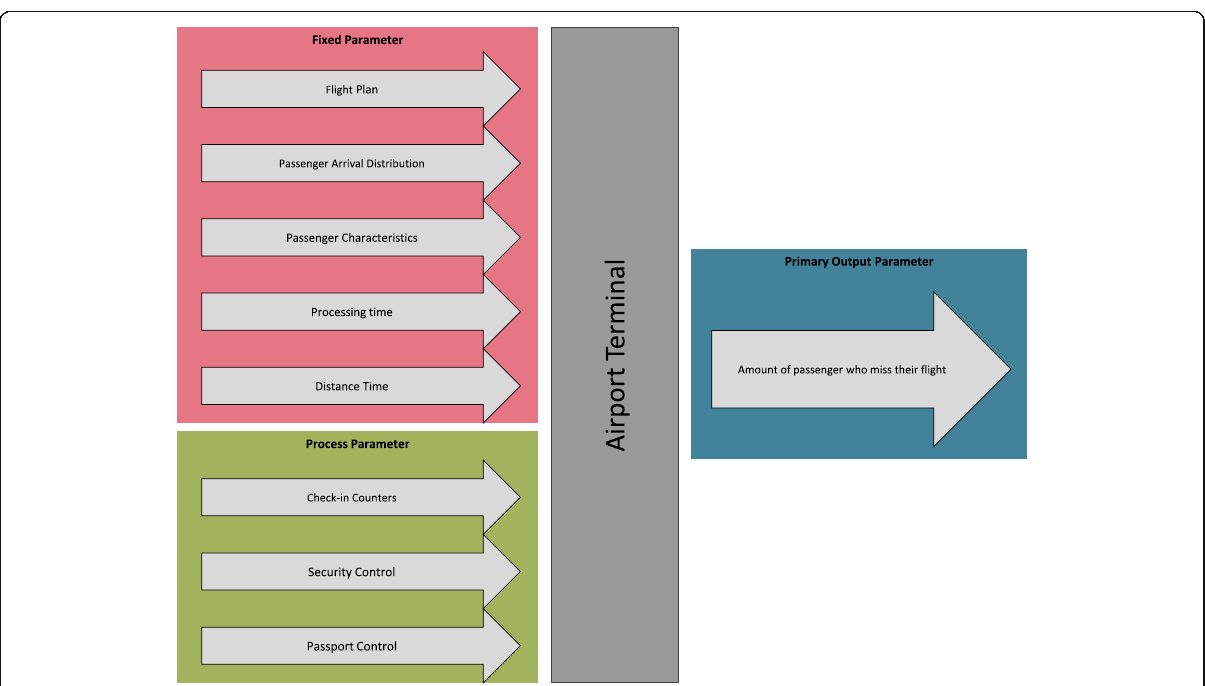
Fig. 3 Overview of the input and output parameters of the simulation. Input parameters are divided into fixed and process parameters. The red rectangle highlights the fixed parameters, which are constant or subject to a predefined probability distribution. The green rectangle contains the process parameter. These indicate the number of available counters at the process stations. The output parameters are shown in the blue